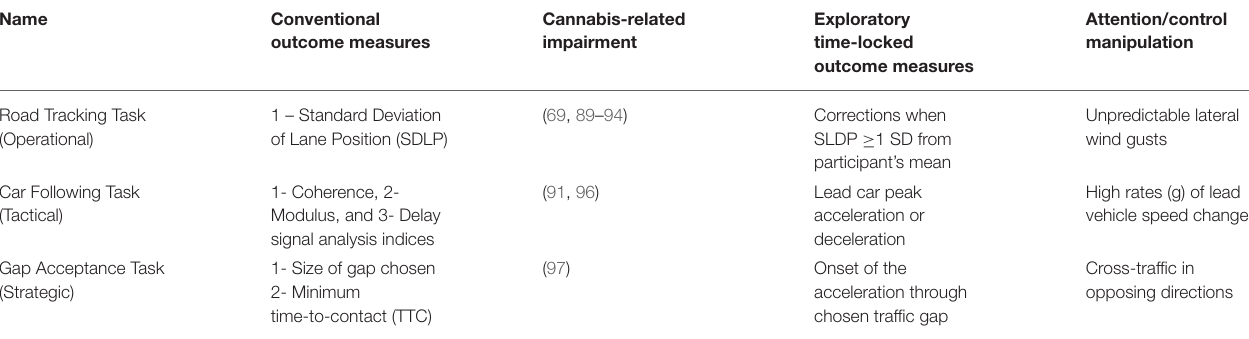
TABLE 3 | Driving scenarios and key outcome measures for 3 hierarchical driving